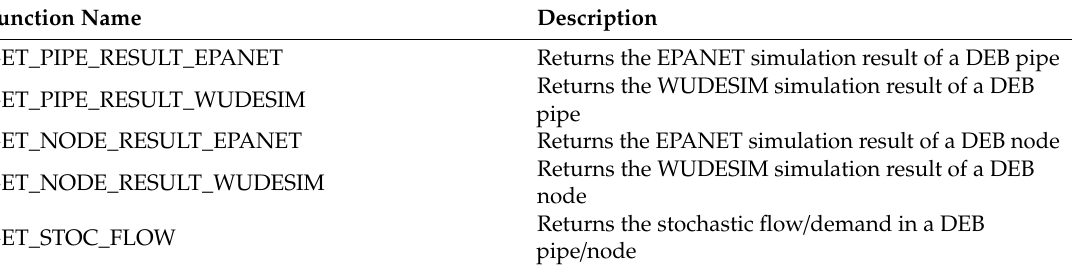
Table 5. Description of Get Result Functions.